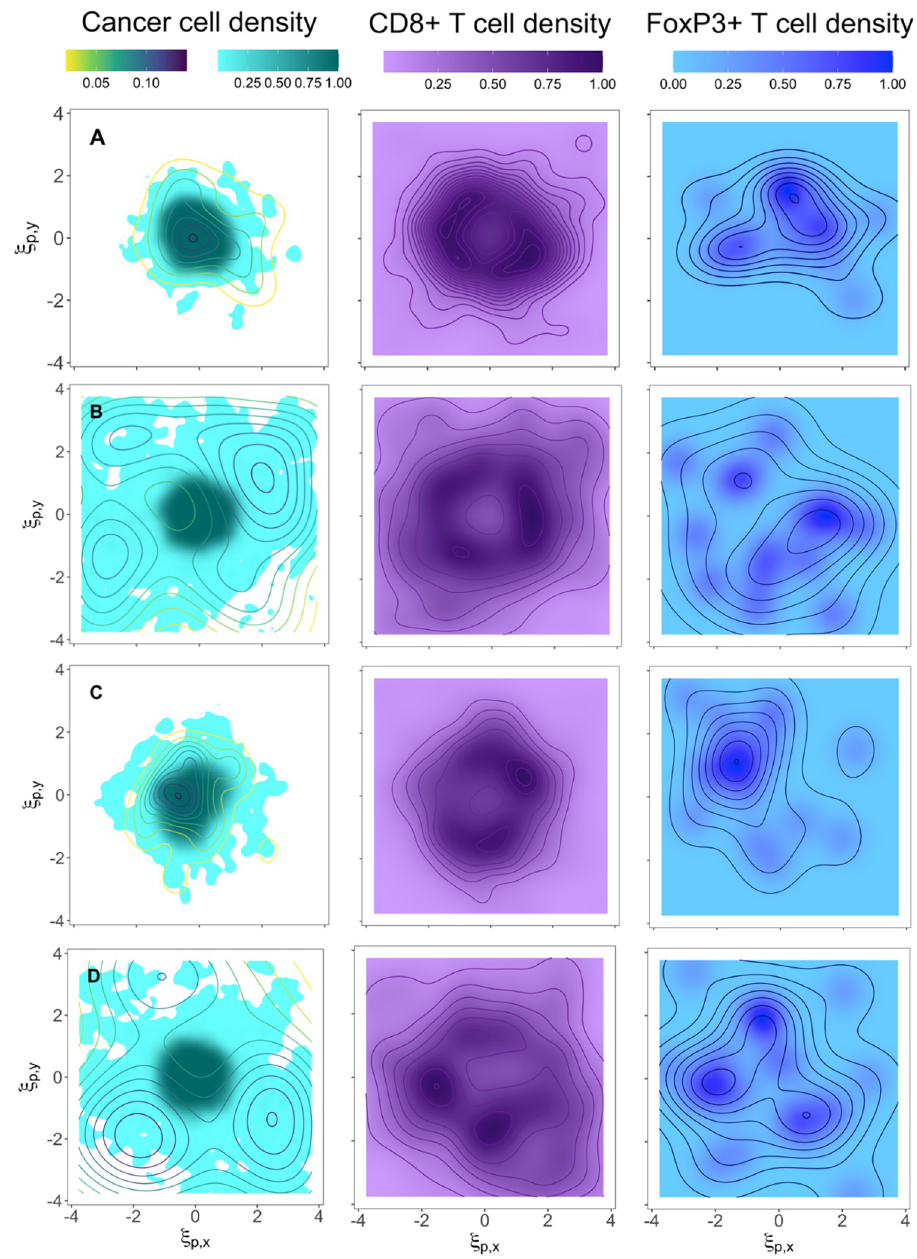
Fig 5. Spatial distributions of cell densities under different tumor growth conditions and immunotherapy. Cancer cell, CD8+ T cell, and FoxP3+ T cell densities are normalized and represented in turquoise, purple, and blue scale bars, respectively. CSC density distributions are represented in the first column of contour plots as yellow-to-blue lines. ξ p,y = y/ y ref and ξ p,x = x/ x ref are non-dimensional spatial coordinates with y ref = x ref = 2u p /r p . Four different scenarios are presented: similar migration and proliferation effects, R ~ 1, 10% of the grid occupied by voxels with cell recruitment sources, and d max = 9 (panel A); fast migration of CSCs and proliferation of PCs, R < 1, 10% of the grid occupied by voxels with cell recruitment sources, and d = 9 (panel B); R ~ 1, 10% of the grid occupied by voxels with cell max recruitment sources, and d max = 4 (panel C); R < 1, 30% of the grid occupied by voxels with cell recruitment sources, and d = 9 (panel D). The spatial QSP algorithm calculated the evolution of three-dimensional tumors starting from max a normal distribution of cancer cells located at the center of the grid. QSP model and ABM are coupled before reaching the point where T cells are recruited and also before the initial tumor diameter condition from the QSP model is met. Thus, no initial T cell spatial distribution is enforced. The figures show the cancer cell density of a two-dimensional slice at the center of the tumor 10 months after the initial tumor diameter condition is met and 3 mg/kg nivolumab is administered every two weeks. The scaling factor is γ =50000 in all cases.